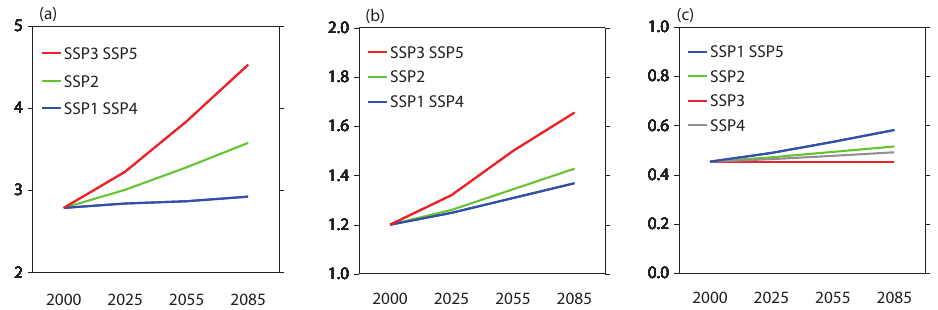
Fig. 9. Scenarios of (a) global total irrigated area (10 6 km 2 ) , (b) global mean crop intensity (crops yr − 1 ) , (c) global mean irrigation efficiency (–).